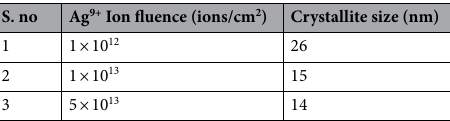
Table 2. XRD results showing the variation in crystallite size with Ag 9+ ion beam fluence.